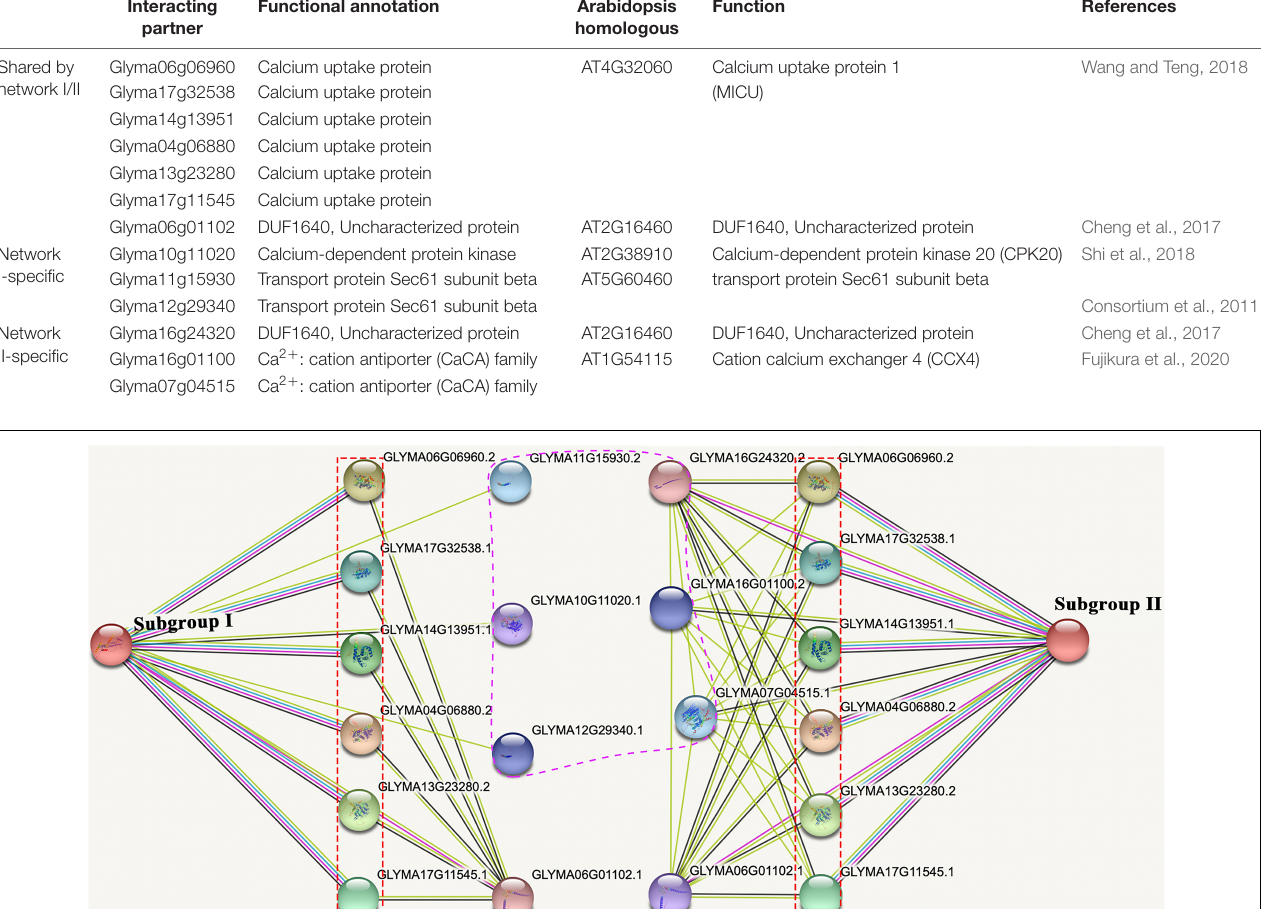
FIGURE 9 | Protein-protein interaction network of soybean MCU proteins. The experimentally determined interacting proteins of the GsMCUs are marked with red boxes. Differences in interacting proteins between the two subgroups are marked by a purple dotted